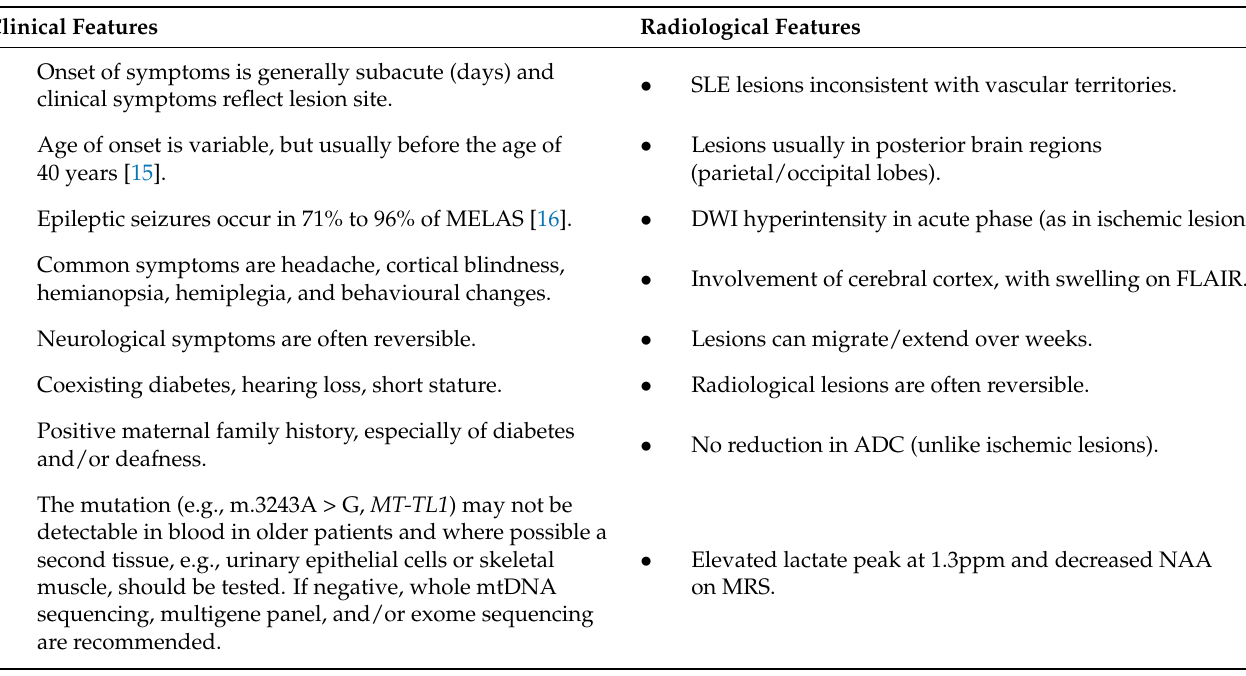
Table 2. Clinical and radiological characteristics of stroke-like episodes due to MELAS. Clinical